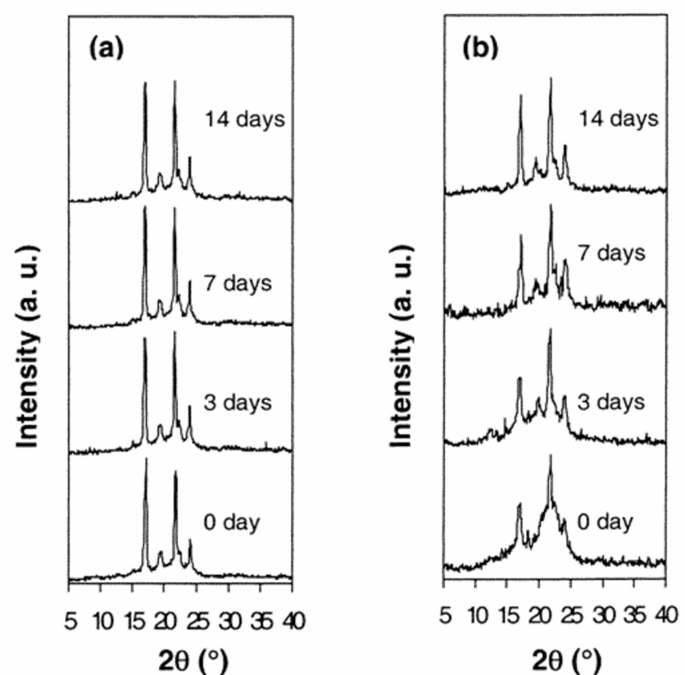
Figure 11. X-Ray di ff raction patterns of as-synthesized ( a ) and coalesced ( b ) PCL-b-LLA films, after various enzymatic degradation times. Reproduced with permission from [41]. Copyright 2003 American Chemical